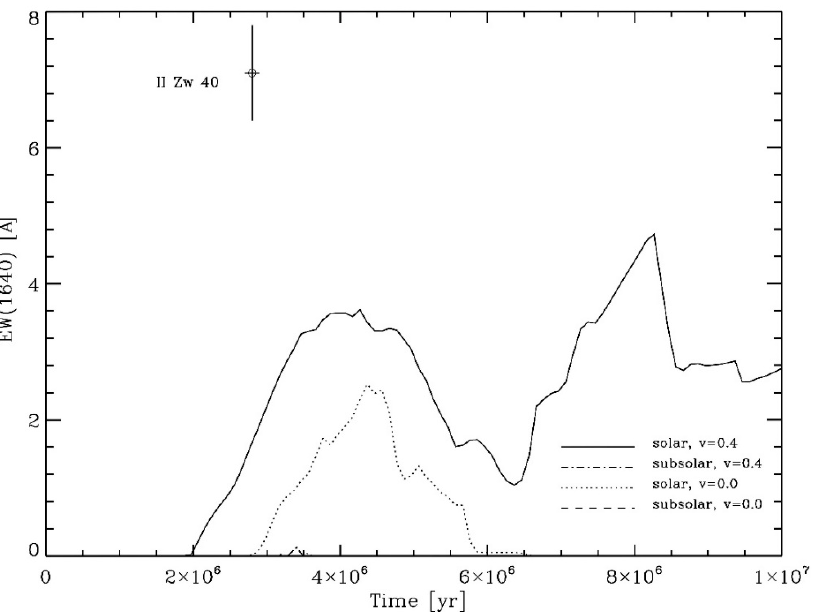
Figure 19. Equivalent width of stellar He II 1640 versus time. The value for SSC-N is the open symbol with error bars. The lines show the predictions from four different simulations: solar and subsolar compositions with and without rotation. The predictions for the two subsolar models are very small at any time and are therefore not visible in the graph. From [76].